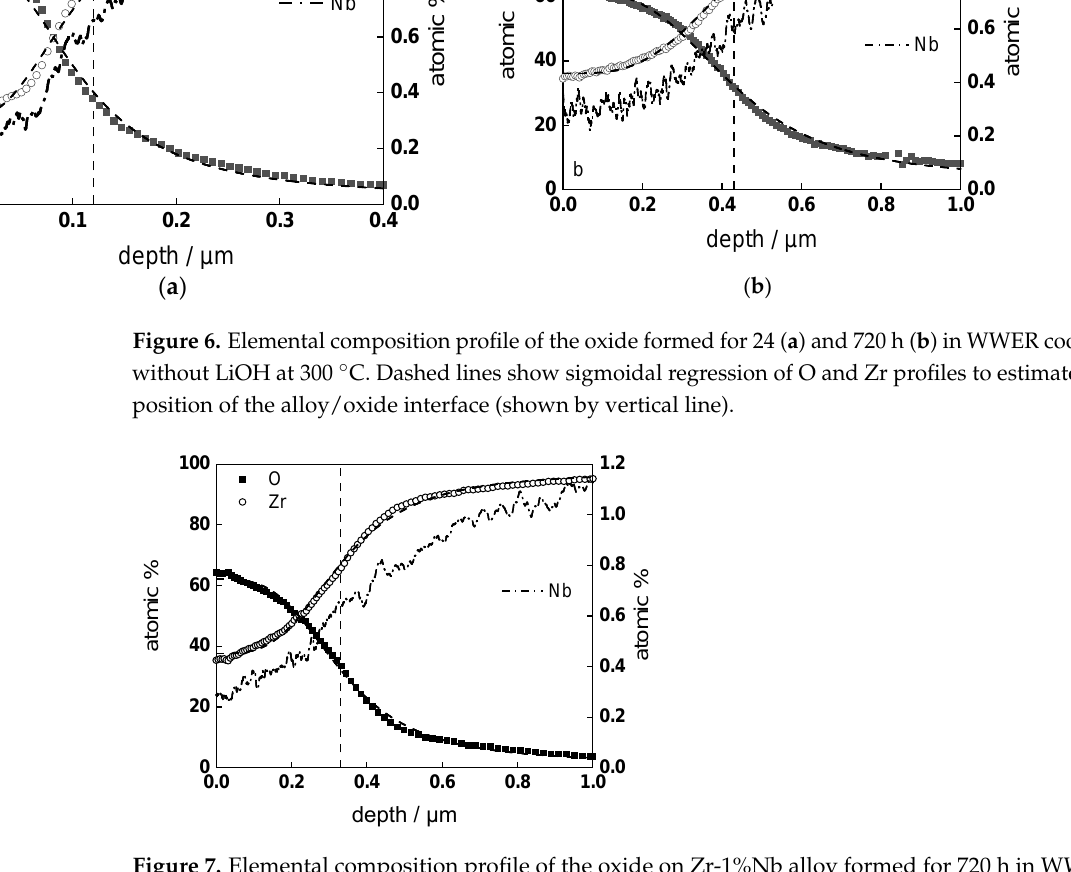
impedance magnitude (full symbols) and phase shift (open symbols) vs. frequency. Points-